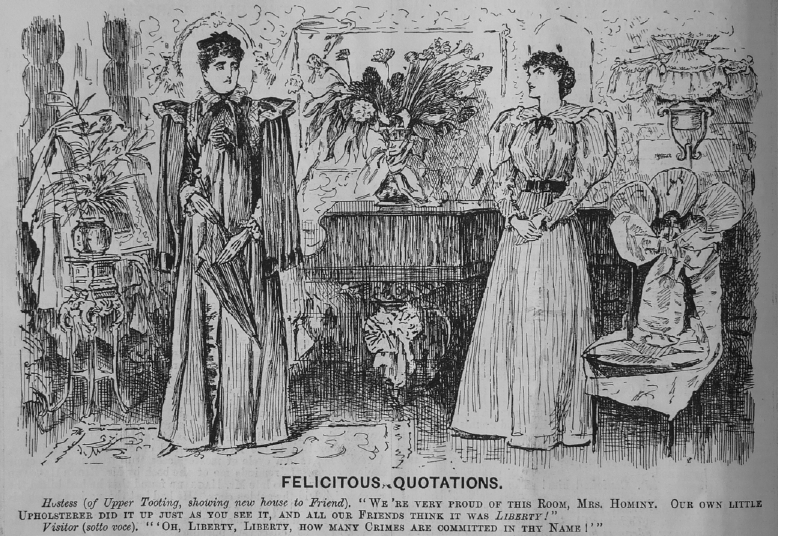
Figure 9: Punch pokes fun at the suburbanites who tried to copy the Aesthetic ‘Liberty’ style on a budget (October 20, 1894. Courtesy Mr I.